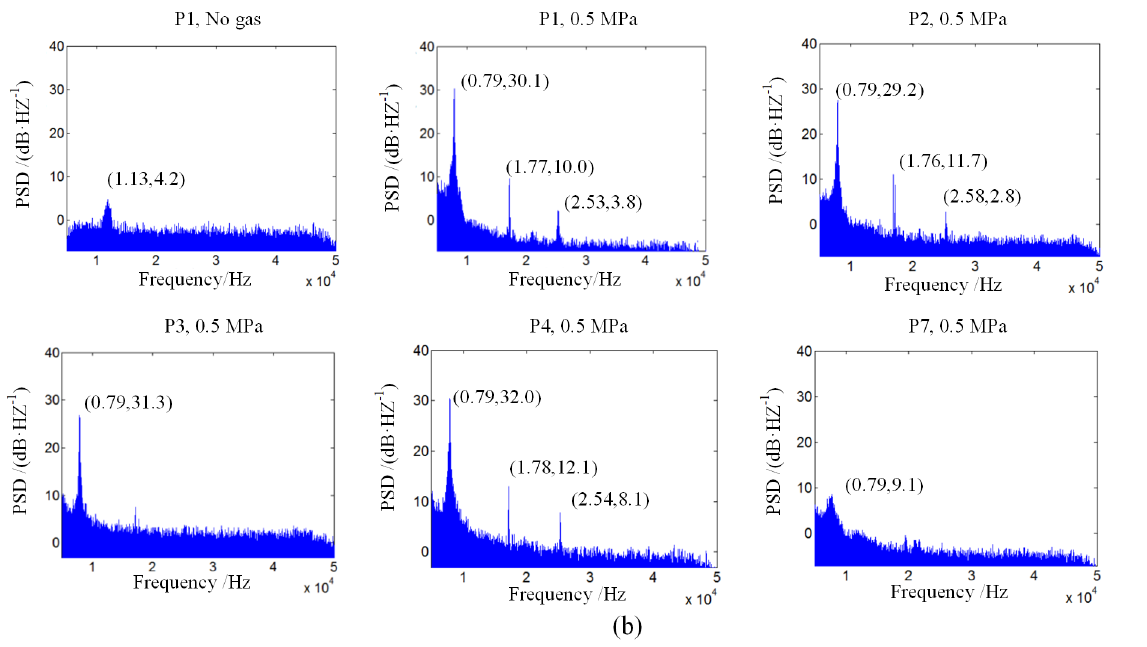
Figure 10. Power spectral density of vibration signals under different air-supply pressures: ( a ) double-ring-grooved [25]; and ( b )